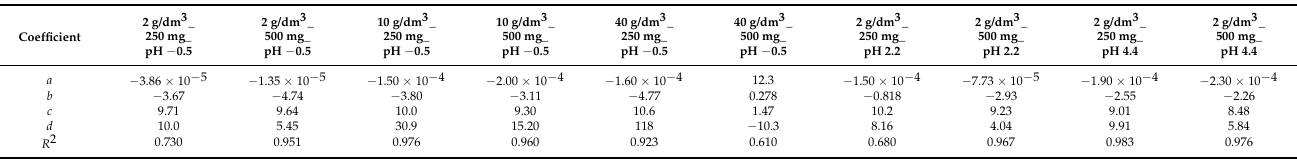
Table A2. a – d parameters of the fitted equation for MAC-3 (abbreviation: initial concentration of Cr(III)_mass of